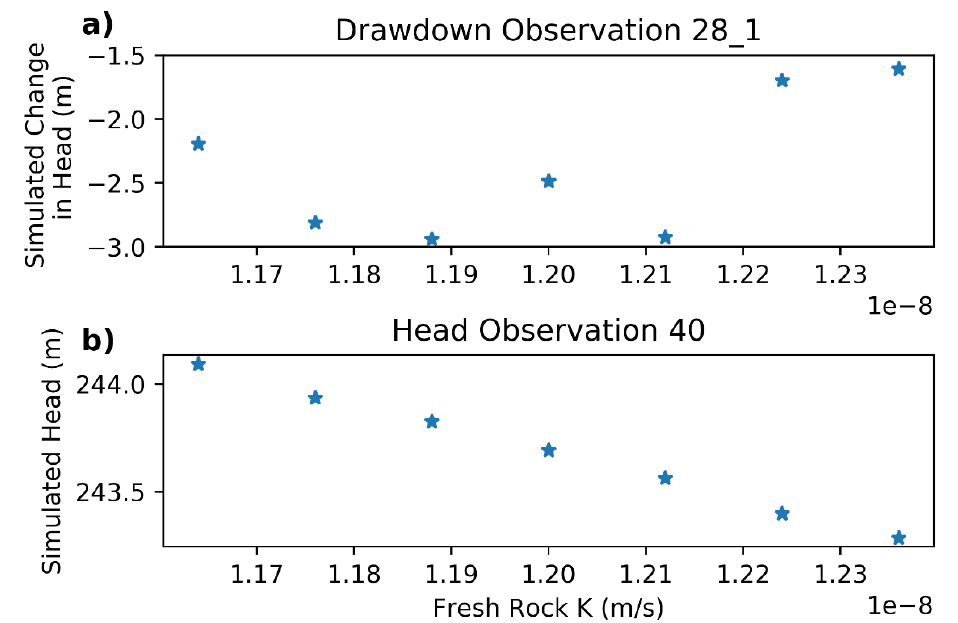
Figure 3. Results of small perturbations to the bulk fresh rock horizontal hydraulic conductivity parameter for simulated ( a ) Drawdown and ( b ) Static head observation. The decreasing trend observed in static head simulations ( b ) indicates that the finite difference approximation captures local model behavior for the steady state simulation. The lack of a linear trend in the drawdown simulation ( a ) indicates that numerical oscillations likely prevent any finite difference approximation based on two or three points from approximating the local model